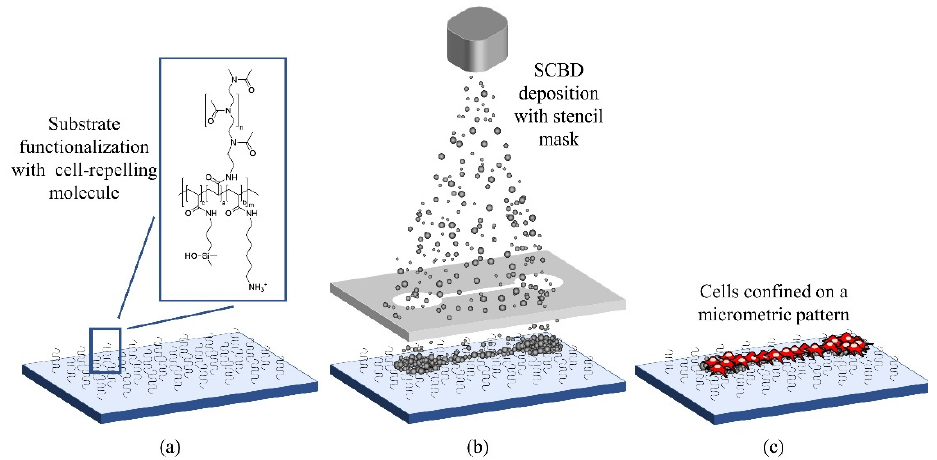
Figure 1. Schematic representation of the fabrication process of substrates for cell confinement. ( a ) The substrate is functionalized with the cell repelling copolymer PAcrAm-g-(PMOXA, NH2, Si). ( b ) A micropatterned film of ns-ZrO x is deposited via Supersonic Cluster Beam Deposition (SCBD). ( c ) Cells are plated on the substrates and they adhere only to the ns-ZrO x pattern. Nanostructured zirconia patterns are deposited by a SCBD apparatus equipped with a pulsed microplasma cluster source (PMCS). The details of nanostructured film fabrication process can be found in References [27,28,34].